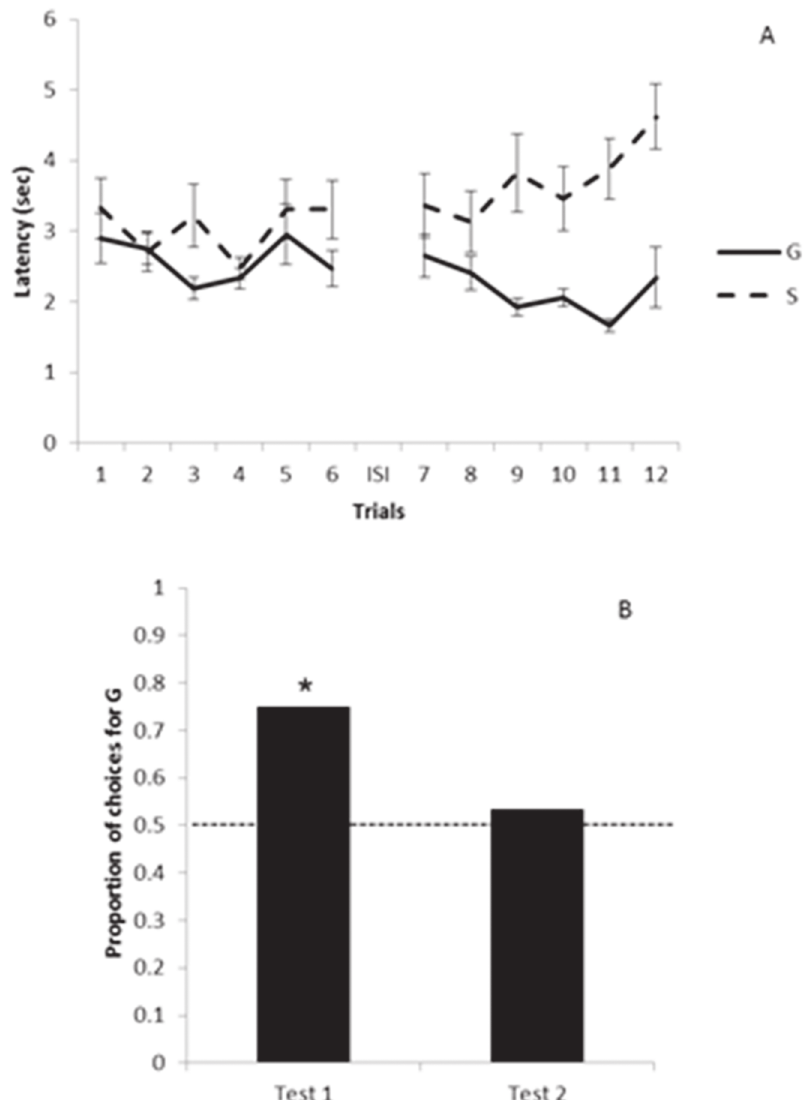
Fig 4. (A) Study 2: Mean latency as a function of trials with the generous and the selfish experimenters. The dashed line represents the latency to approach the selfish (S) experimenter, whereas the full line represents the latency to approach the generous (G) experimenter. ISI: inter-session interval. Error bars denote ± 1 sem. (B) Study 2: Proportion of choices for the generous (G) over the selfish (S) experimenter. The horizontal dashed line indicates the 0.50 chance level. * : p <